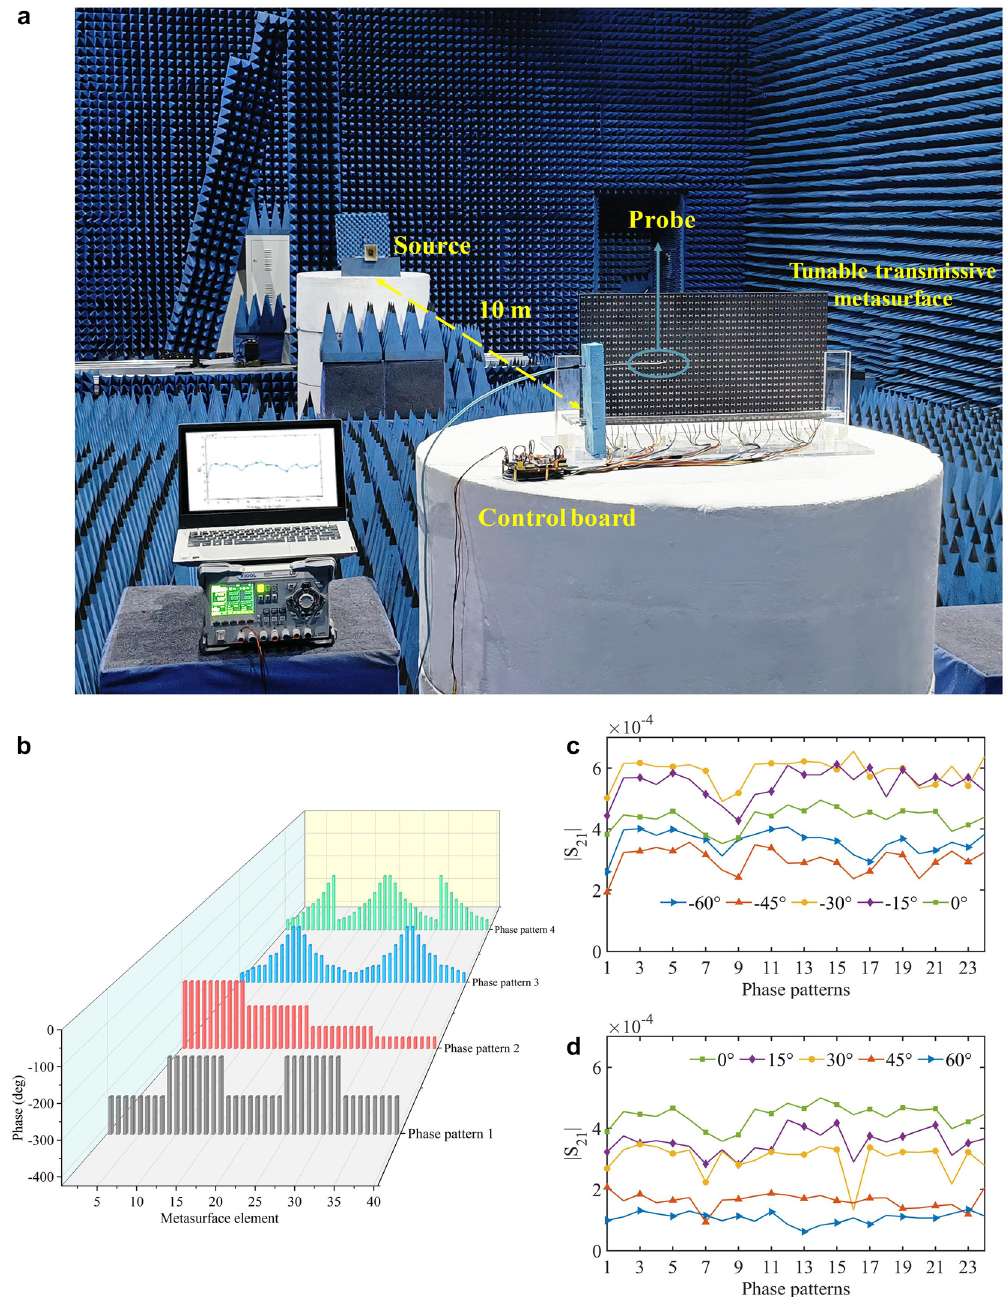
Figure 4: Experimental setup and field intensity distribution in specific phase patterns. (a) The TM polarized transmitting antenna is placed approximately 10 m in front of the metasurface (Supplementary Note 2). The probe is placed 4 cm behind the metasurface, and they are held in the same position relative to each other on the turntable. In this scenario, the rotation of the metasurface causes the transmitting antenna to be relatively tilted such that the beam is obliquely incident into the metasurface. When there are incoming waves, the metasurface will perform multiple phase pattern updates for manipulation. The probe receives the transmitted waves in real time and feeds the data into the RF to instantly obtain the incident angle. (b) Phase patterns for transmission wave regulation. Among them, phase patterns 1 and 2 change steeply, whereas phase patterns 3 and 4 increase or decrease gradually along the x direction. (c) and(d) The fi eld intensity distribution of incoming waves from a wide range of directions after passing throughthe metasurfaceinvarious phasepatterns. The variationsof transmittedwaves fromthe samesideare similar.See additionaldetails in Supplementary Note